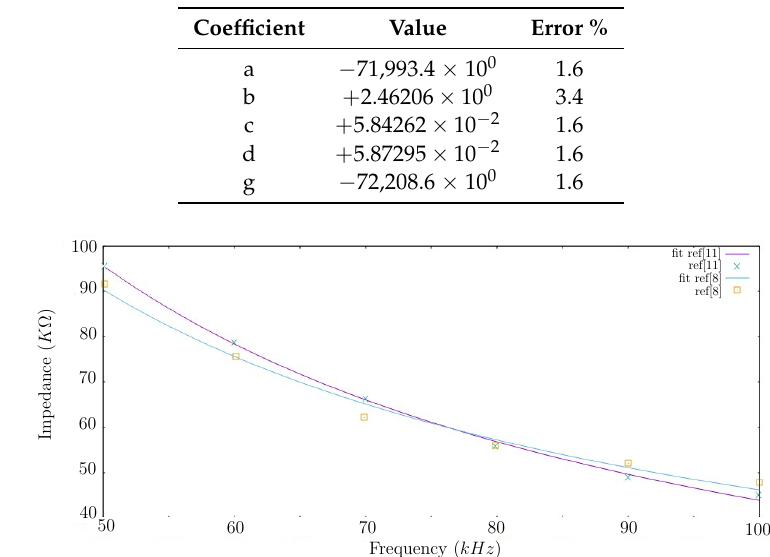
Table 3. Coefficient values from Equation (19) and percentage errors with respect to data obtained from [11].